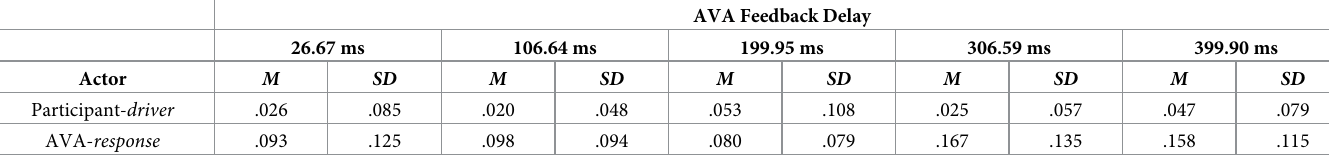
Table 1. AVA testing trials: Driver and response LLE